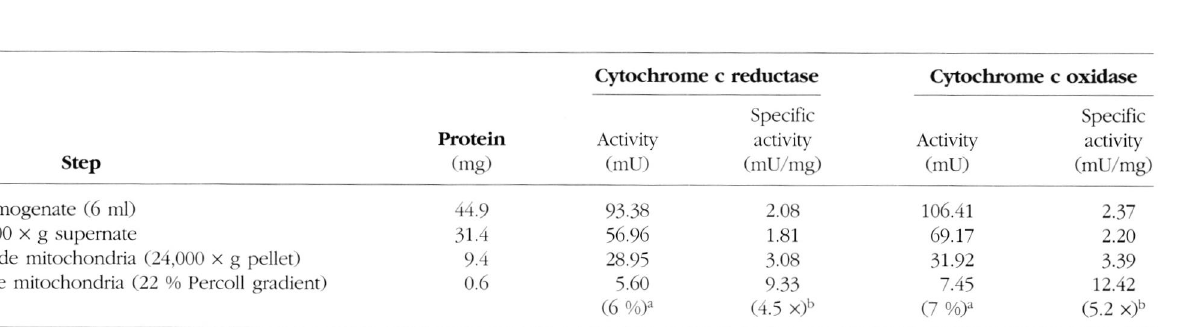
Table I. - Activities of mitochondrial marker enzymes during the organelle isolation from 1.0 ml (-5 x 10 11 cells) of purified sexual stages of P.